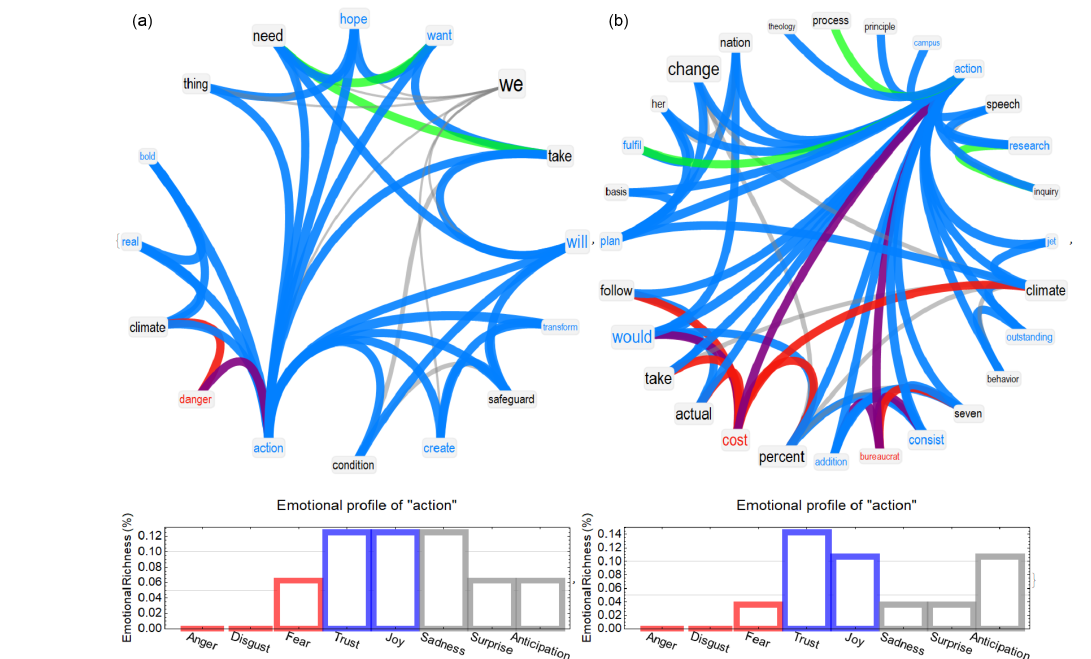
Figure A5. Speakers’ mindset reconstruction around “action” in the speeches of Greta Thunberg (a) and Christopher Monckton (b) . We refer the reader to Fig. 1 for a detailed explanation of the colour code and to Lexicon 1 for an interpretation of the figure.